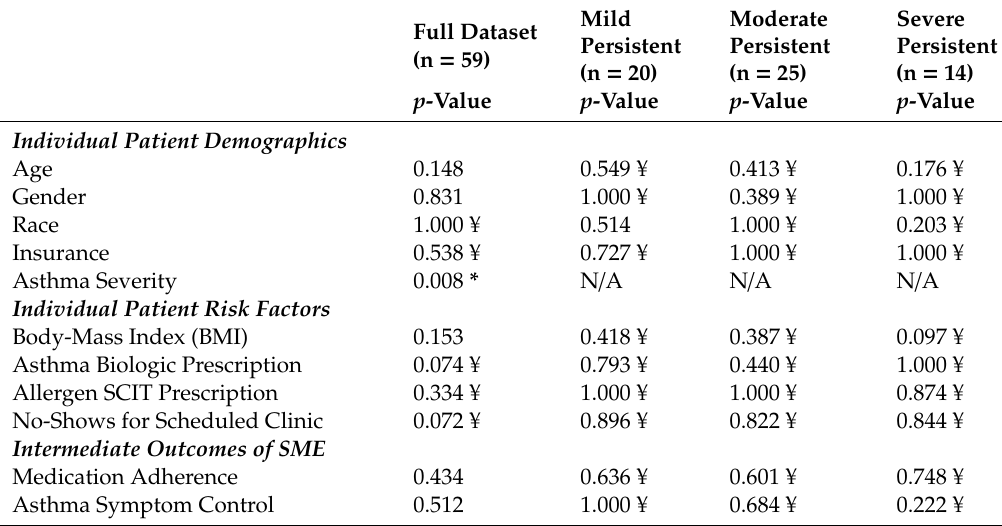
Table 2. Di ff erences between users and non-users of unscheduled healthcare in childhood asthma, by individual demographic and risk factors: results from contingency table